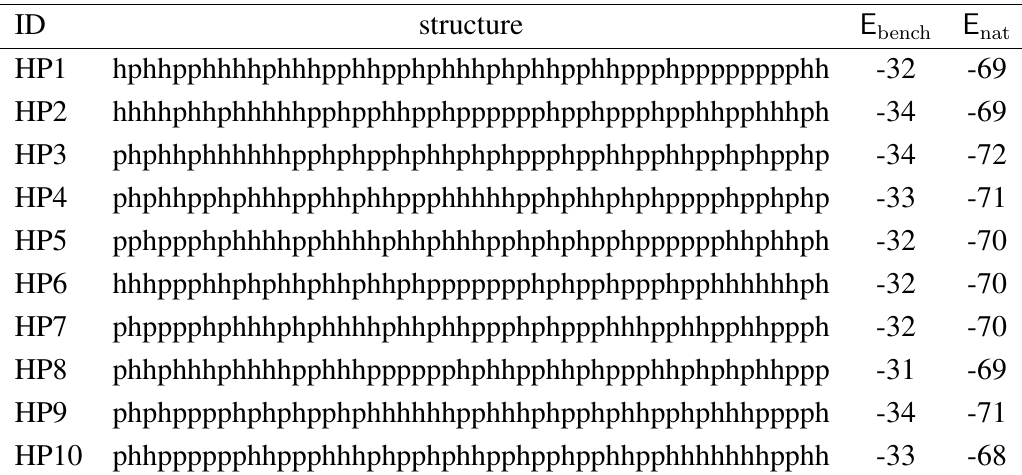
the corresponding value nat